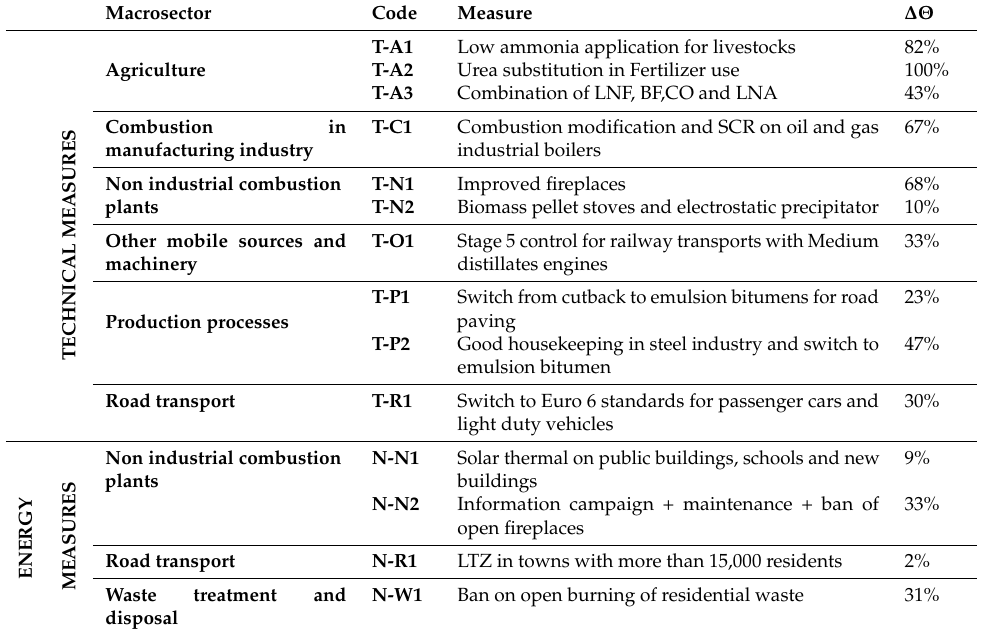
Table A3. Final measures chosen to undergo the second Step of the methodology with the final ∆Θ values for Policy A.